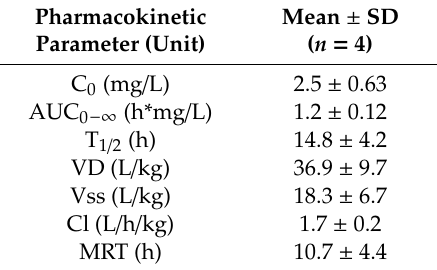
Table 5. Pharmacokinetic parameters (mean ± SD) of GMC1 in SD rats following a single 2 mg / kg IV bolus dose of